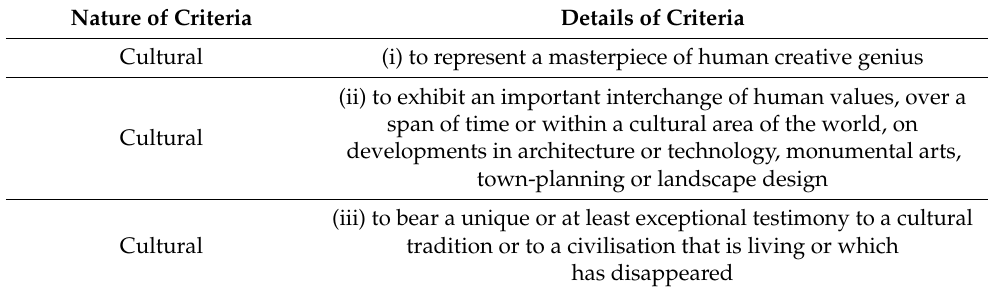
Table 1. Criteria for nomination and inscription of World Heritage Sites [7]. Nature of